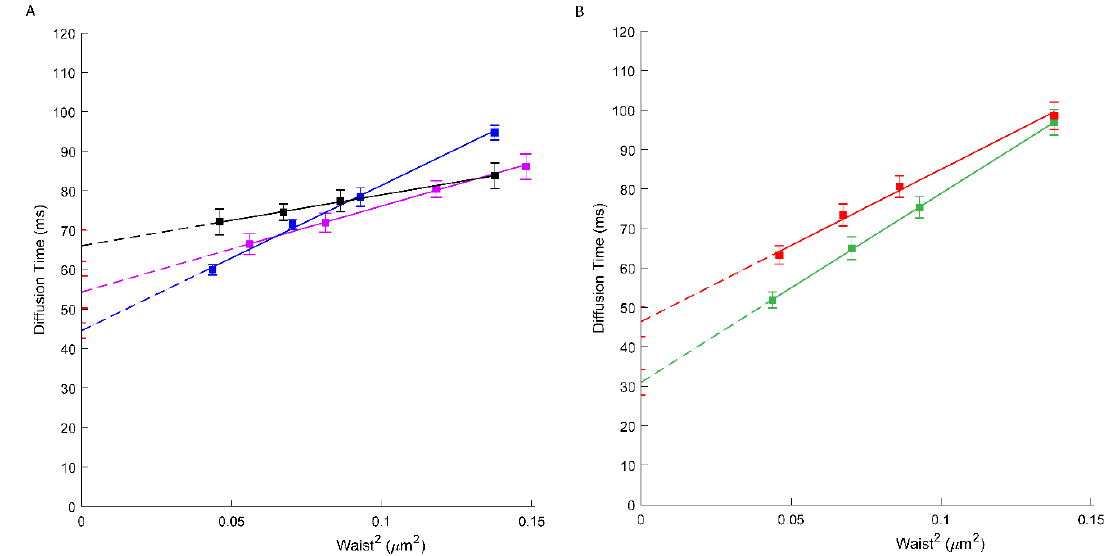
Figure 3. ( A ) svFCS diffusion laws for an active ABCA1 in non-treated A1G cells (black), after cholesterol oxidase treatment (blue) and after reload with cholesterol-methy- β -cyclodextrin (violet). ( B ) svFCS diffusion laws for a non-active ABCA1MM in non-treated MMG cells (red) and after cholesterol oxidase treatment (green).